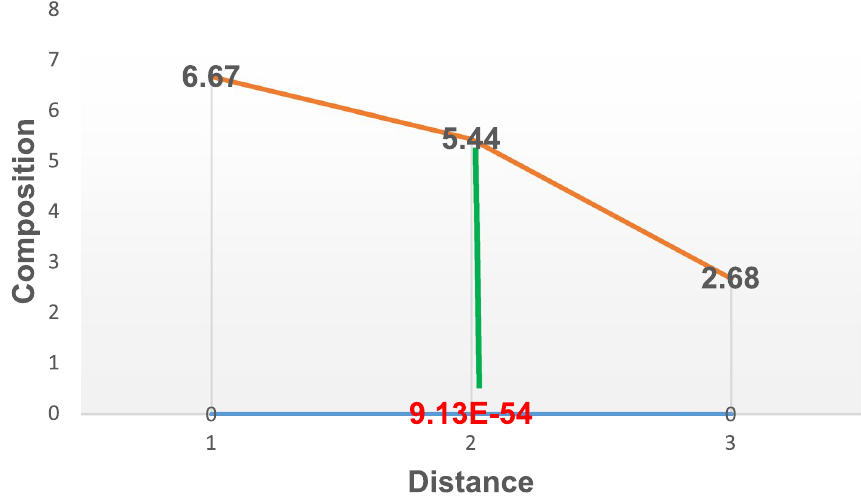
Figure 4. Diffusion of carbon atoms into the surface of grey cast iron at 900° for 120 min.